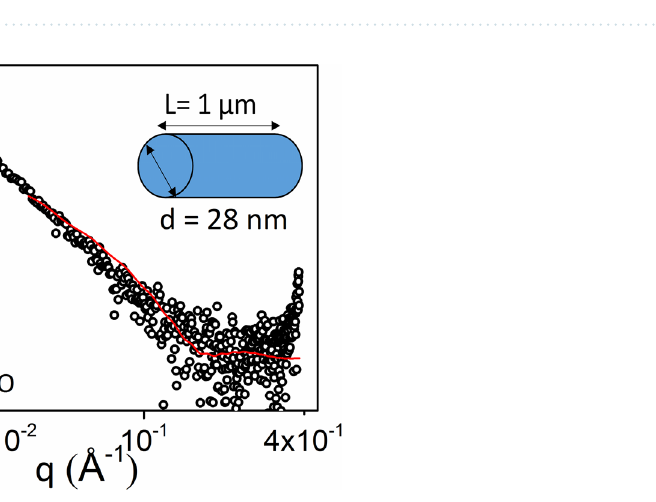
Figure 3. XRD pattern data of ( a ) GO (green) and composite (red) samples and ( b ) Py NWs inside AAO template.